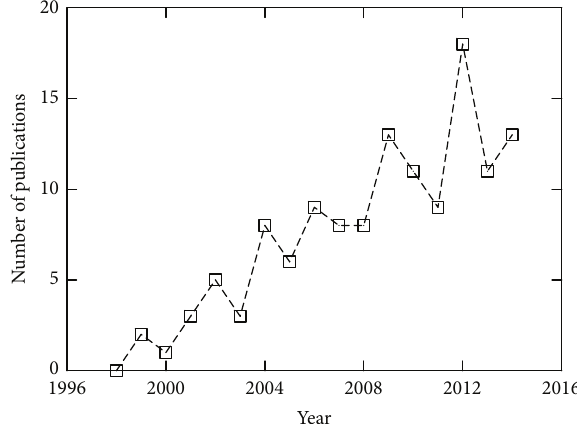
Figure 1: Number of publications regarding the numerical opti- mization of compressors using CFD per year in Scopus [12].